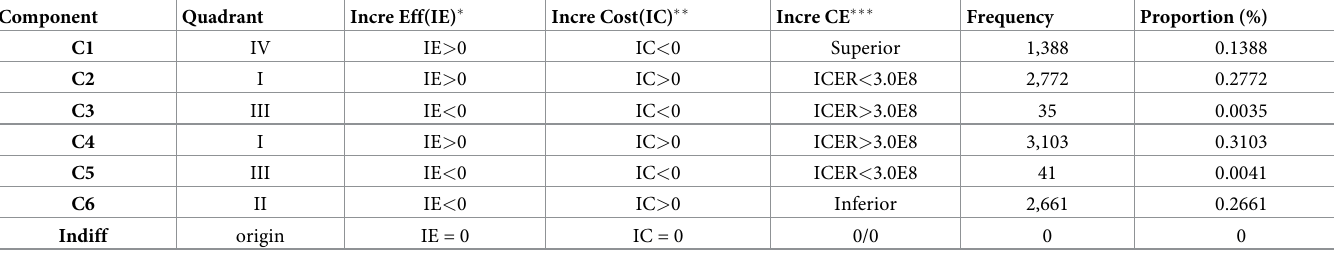
Table 3. Report of the cost-effectiveness probability in each cost-effectiveness plane